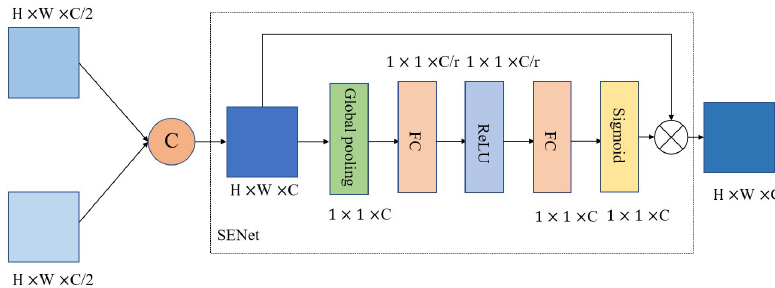
Figure 2. Network structure of the optimized feature fusion